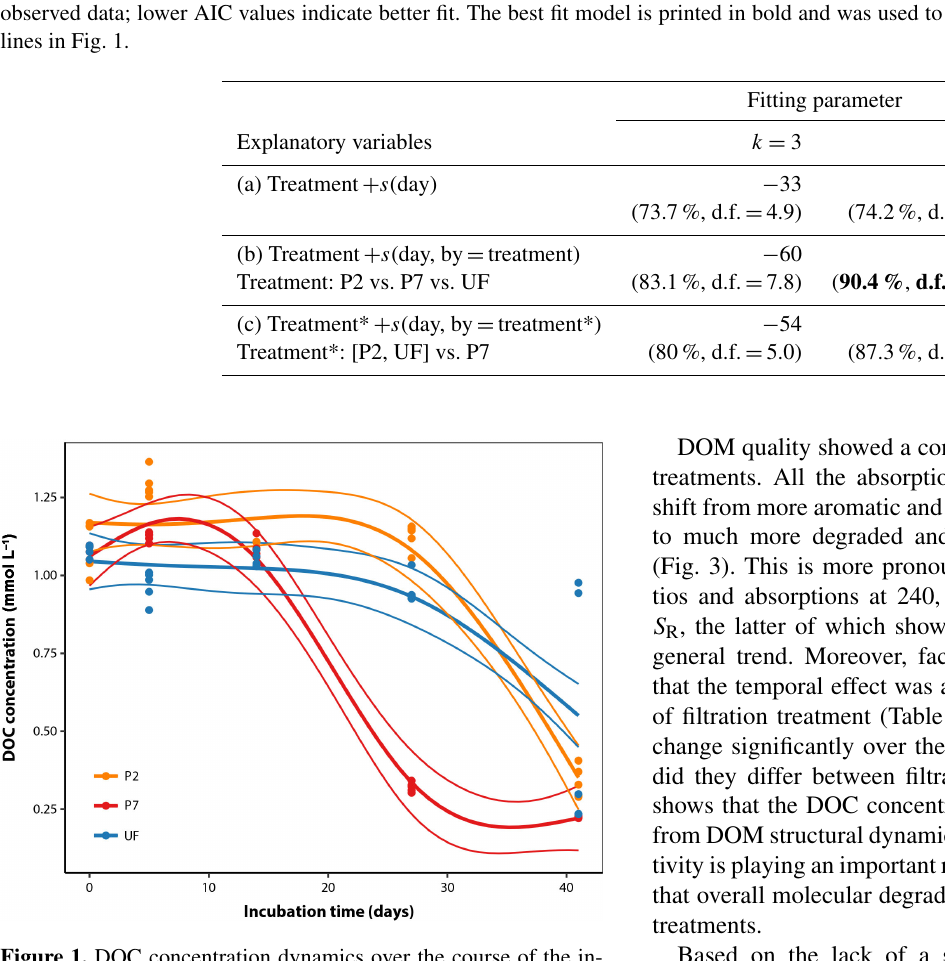
Figure 1. DOC concentration dynamics over the course of the in- cubations for the three filtration treatments. The thicker smoothed lines represent the best-fit GAM as selected using AIC (see Sect. 2.6); thinner lines define the bounds of the 95% prediction intervals derived from the model fits, with standard error estimates pooled across all observations (Table